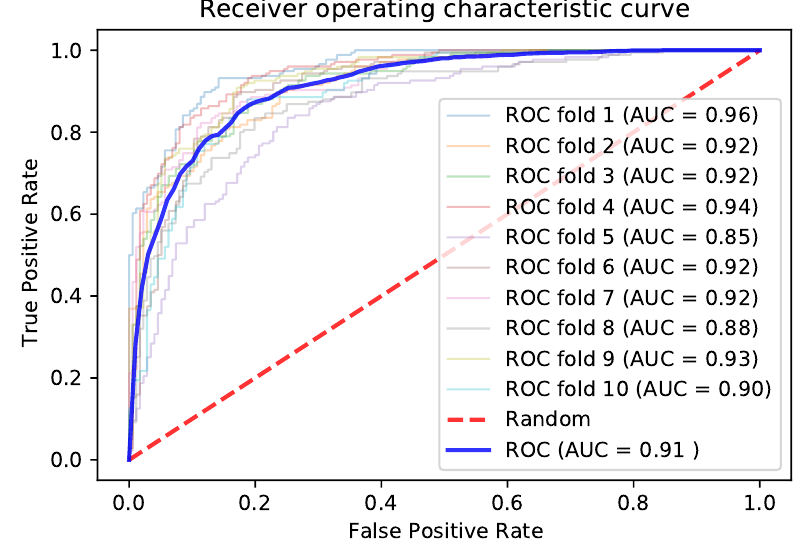
Figure 5. AUCs of 10-fold cross-validation of Tobacco species